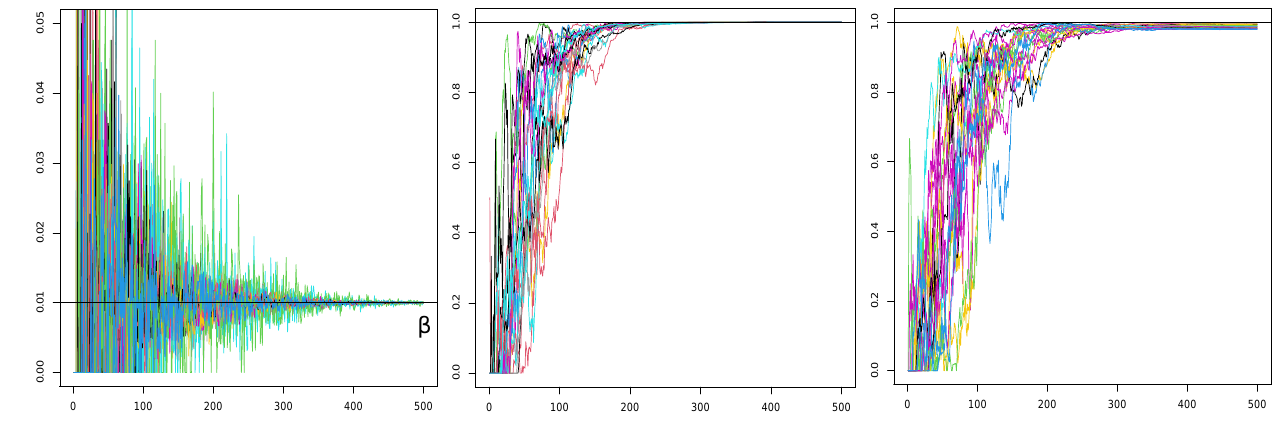
Figure 2. Plot of Z r n / Z n , for several paths on coexistence set of a process when m r < ( 1 − β ) m R ( left ), m r > ( 1 − β ) m R ( middle ) and m r = ( 1 − β ) m R ( right ).